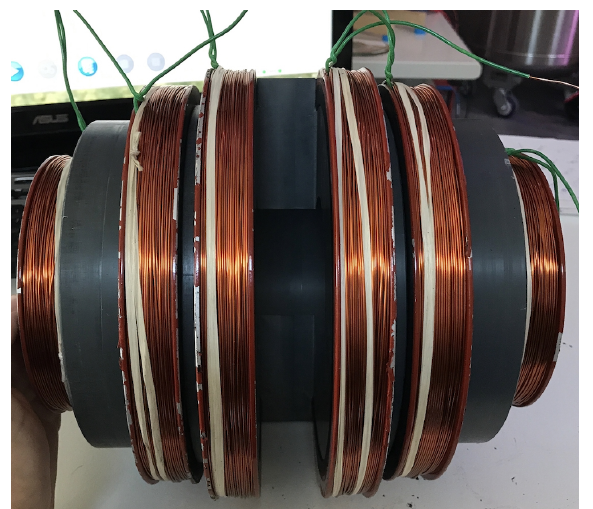
Figure 7. Portable NMR prototype based on a constrained SHS 6 model at 333kHz for agronomic studies ( R = 100mm, N n = 320, window of wire winding: 18mmmm × 15 layers, r c = 0 . 4mm and the prototype total weight =